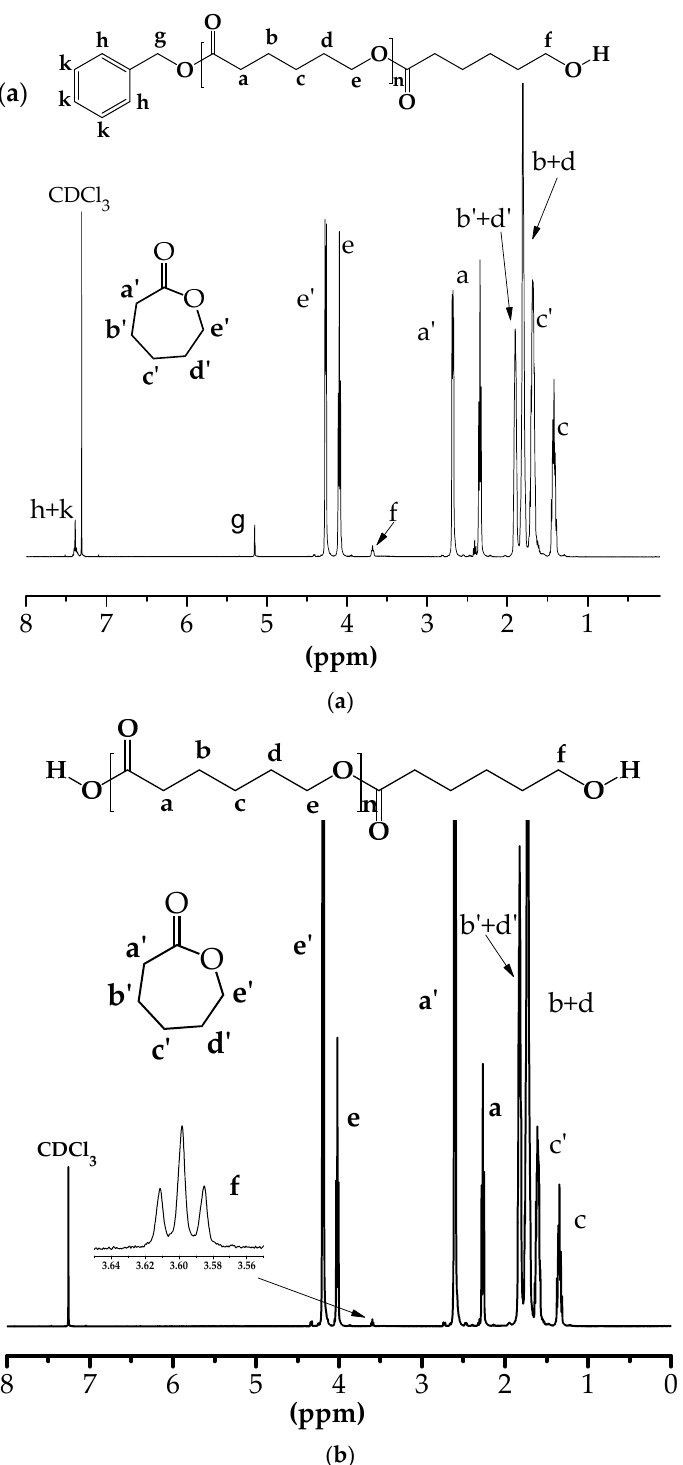
Figure 3. 1 H NMR spectra (CDCl 3 , 25 °C) of poly( ε‐ caprolactone) synthesized via HPCP ‐ catalyzed ROP of ε‐ caprolactone ( a ) with BnOH (run 3, Table 1) and ( b ) without BnOH (run 10, Table 2).